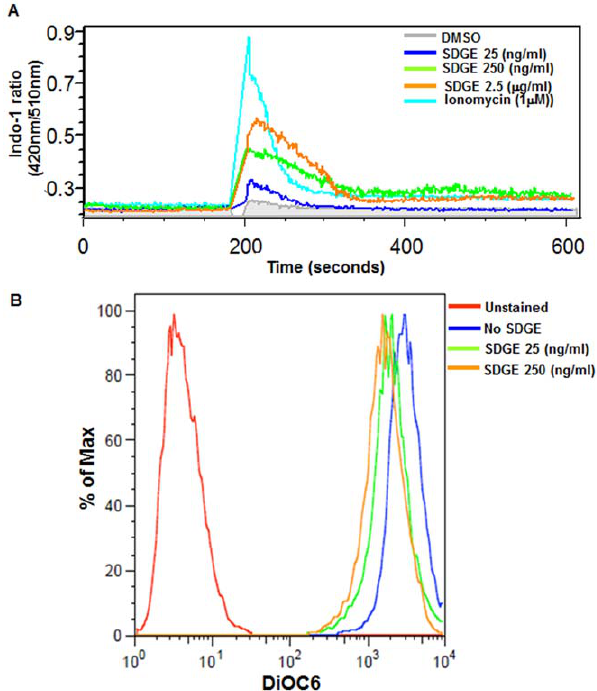
Figure 5. SDGE increases intracellular calcium and decreases the mitochondrial membrane potential of endometrial cancer cells. Effect of SDGE on the intracellular calcium flux was determined by treating Indo-1 loaded Ishikawa cells (A). Immediately after addition of SDGE to the cell suspensions, the Ishikawa cells were flowed through the cytometer and increase in fluorescence was measured to detect calcium flux. Decrease in mitochondrial membrane potential was detected by loading Ishikawa cells with DiOC6 (B). SDGE or vehicle control was added to the cells. After 24 h of treatment, the cells were harvested and incubated with DiOC6 for 15 min. Fluorescence was measured to determine changes in mitochondrial membrane potential.